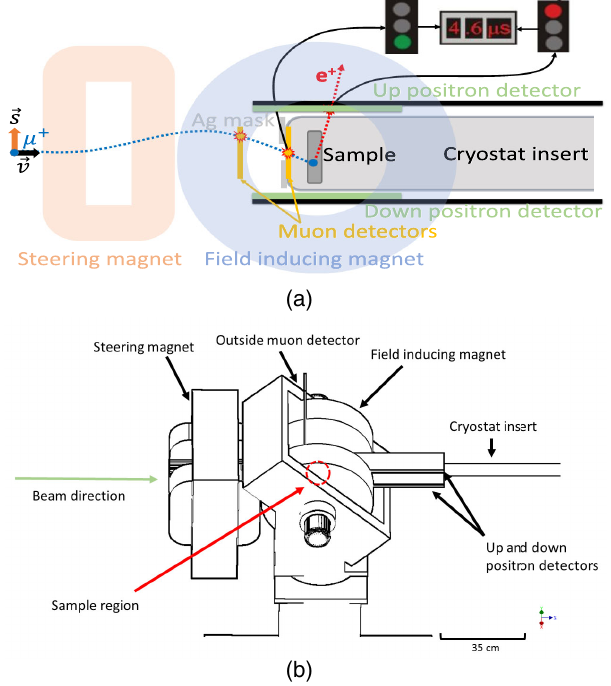
FIG. 2. (a) Schematic displaying the components of the HPF spectrometer and the beam trajectory (b) 3D render of the spectrometer. In the LAMPF spectrometer (not shown) the orientation of the magnetic field is parallel to muon momentum, therefore a steering magnet is not